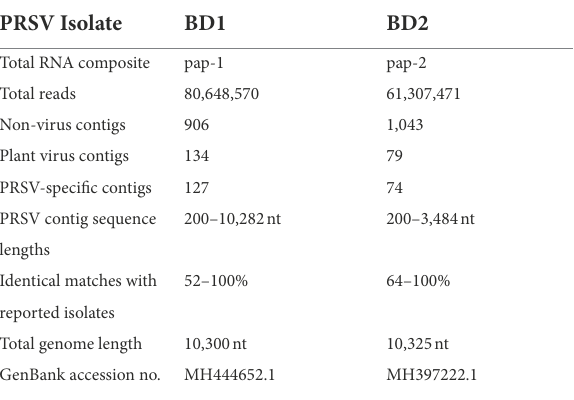
TABLE 2 Illumina ® NextSeq 500 RNA sequencing of whole papaya ringspot virus (PRSV) genomes from symptomatic papaya leaf samples collected in Bangladesh and stored in RNA later ®